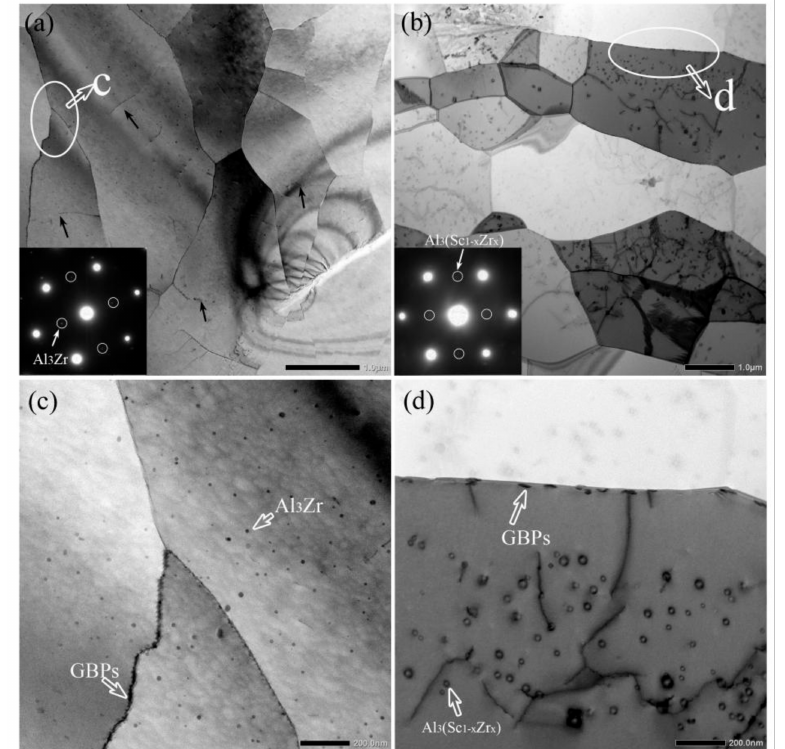
Figure 7. TEM bright field micrographs and corresponding SAED patterns of naturally aged Al- Zn-Mg-Cu alloys in the intermediate layer. ( a , c ) Al-Zn-Mg-Cu-Zr alloy, ( b , d ) Al-Zn-Mg-Cu-Sc-Zr